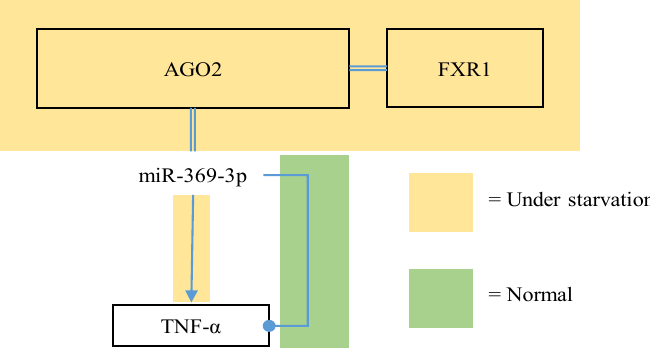
Figure 5. A diagram illustrating the ability of miR ‐ 369 ‐ 3p to upregulate its target TNF ‐α under starvation, but to conversely repress it under normal starvation, but to conversely repress it under normal conditions.